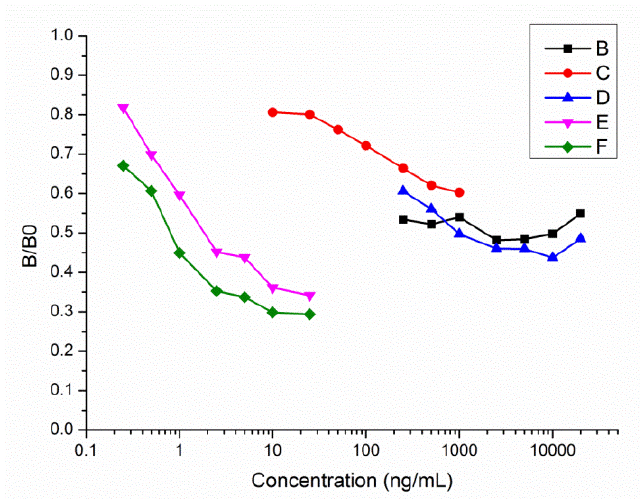
Figure 2. Inhibition curves of polyclonal antibodies from mouse M2 and M3 by icELISA. B represents antiserum from M3 after the fourth immunization; C represents antiserum from M3 after the sprint immunization; D represents antiserum from M2 after the fourth immunization; E represents antiserum from M2 after the fifth immunization; F represents antiserum from M2 after the sprint